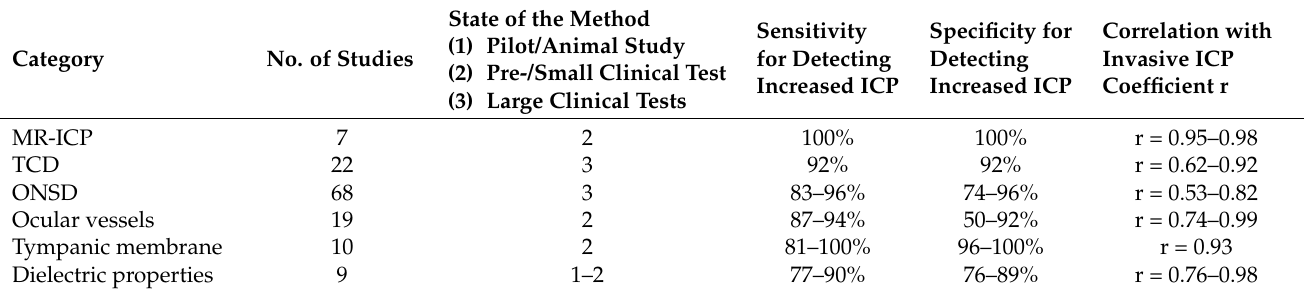
Table 2. Overview of main studies for non-invasive intracranial pressure